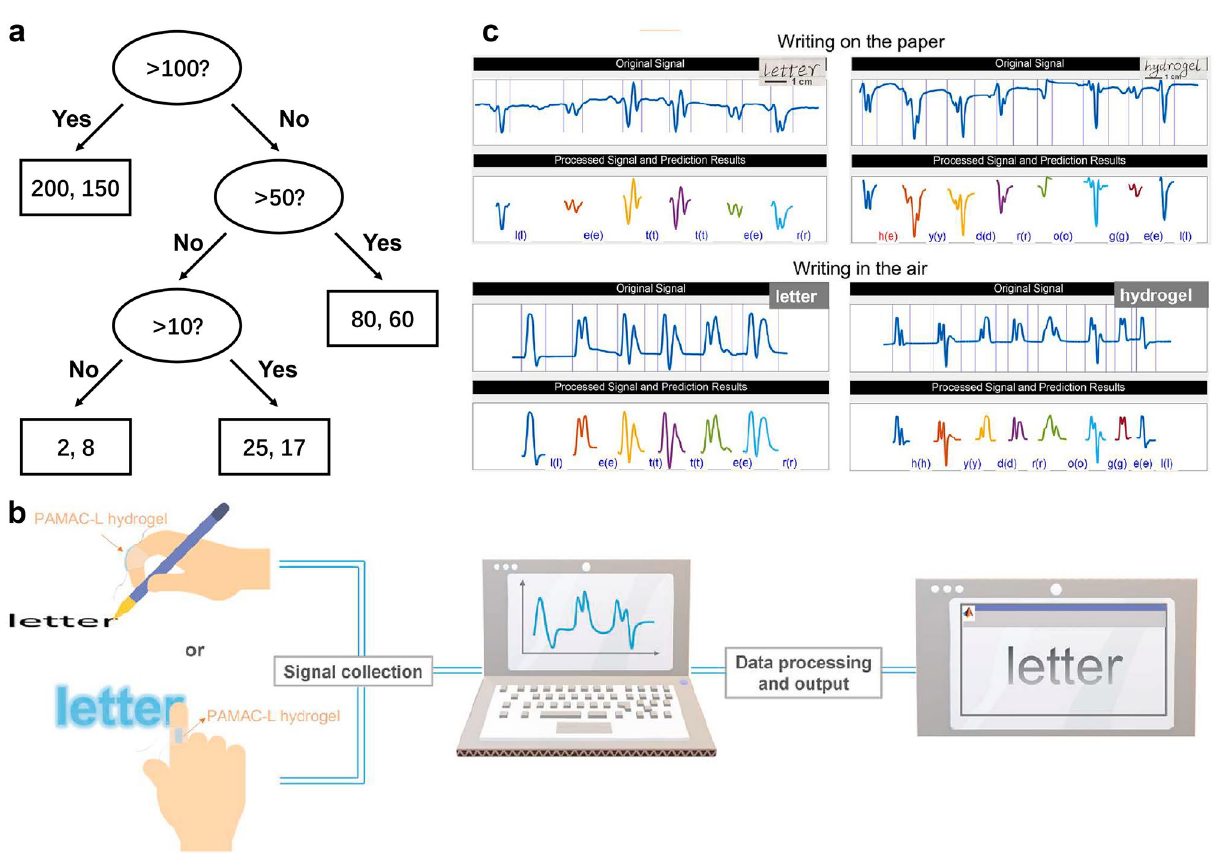
Fig. 23 Signals detected by the soft system and processed by DT. a Schematic diagram of DT. b Schematic diagram of the handwriting recogni- tion system. c Recognition results from the software for handwriting of the word “letter” and “hydrogel” on the paper and “letter”, and “hydro- gel” in the air. Reproduced with permission [317]. Copyright (2022),